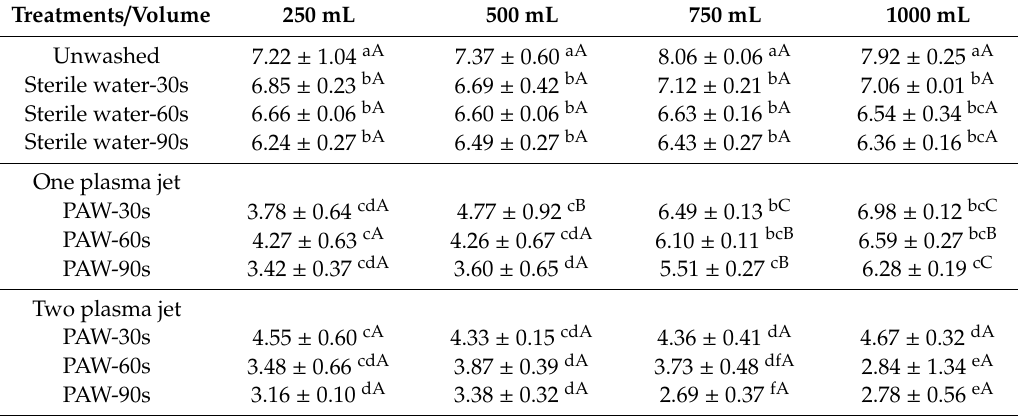
Table 2. The populations of Salmonella Enteritidis (log CFU / egg) on eggs treated by the plasma-activated water (PAW) generated with one or two plasma jets at 6 slm air flow with di ff erent treatment times and volumes.